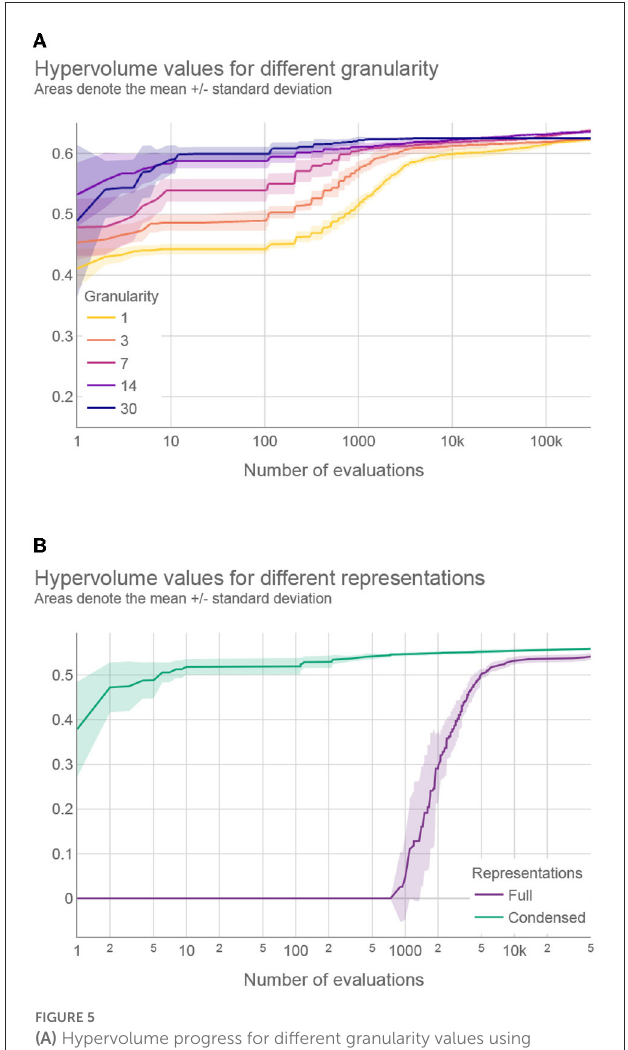
FIGURE5 (A) Hypervolume progress for different granularity values using condensed representation and (B) hypervolume progress for full and condensed representations with the best performing granularity values. A logarithmic scale is used for the horizontal axis (number of evaluations).